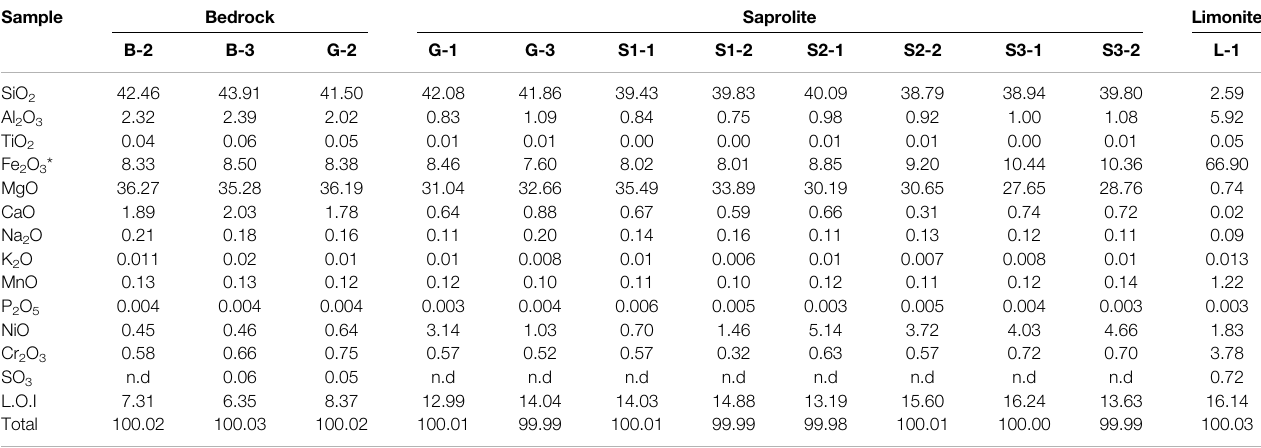
TABLE 4 | XRF data of bedrock, saprolite, and limonite horizon samples (in wt%).